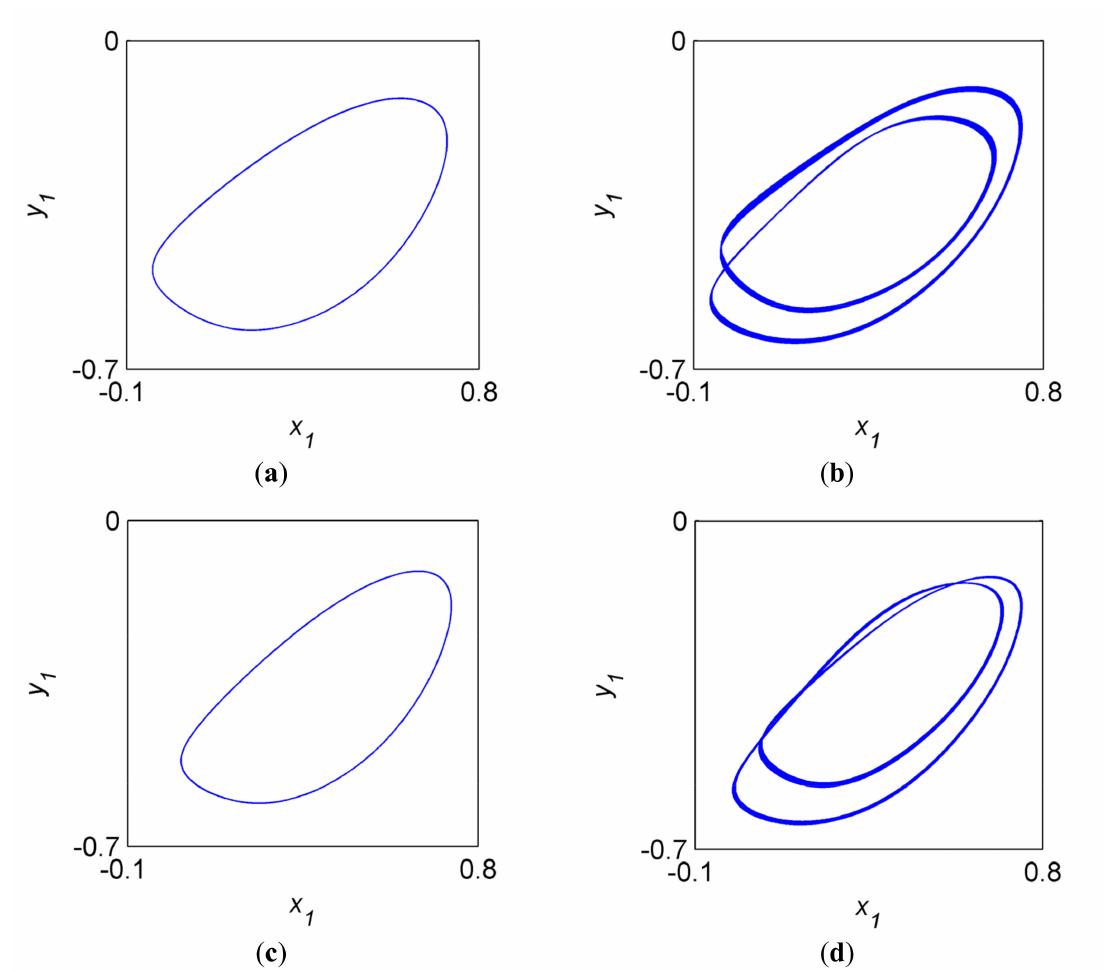
Figure 9. Trajectories of the orbit of shaft center of o 1 when ω = 730 rad/s. ( a ) The oil-filmed system. ( b ) The cracked system. ( c ) The rub-impacted system. ( d ) The coupled system. Figure 9 analyzes the trajectories of the orbit of shaft center of the four di ff erent system when ω = 730 rad/s. The motion curves of the oil-filmed and rub-impact systems (Figure 9a,c) are similar to ellipse. In comparison to Figure 9a,c, double-loop curves are embodied in the cracked and coupling systems. There is one intersection in the cracked system and two intersections in the coupling system, this result indicates that the crack fault is a key factor in the appearance of double-loop curves at 2 ω c . The rub-impact fault may a ff ect the topological structures of the double-loop